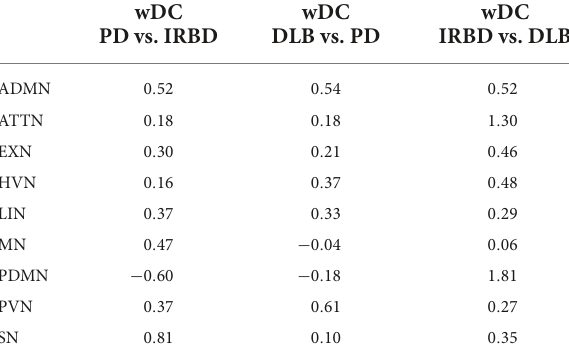
TABLE 3 wDC coefficient for comparison in clinical